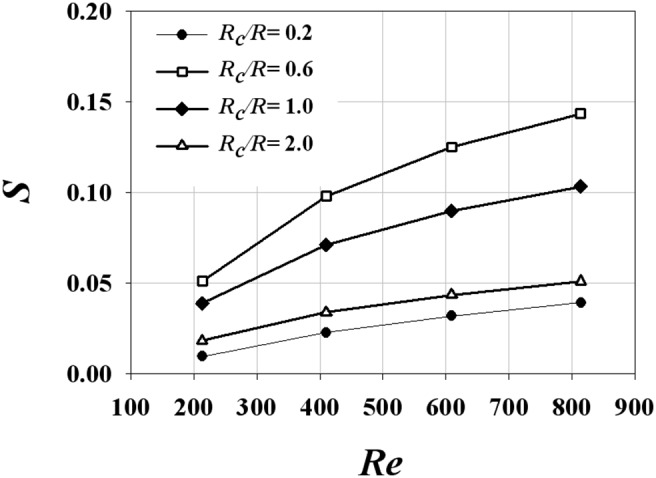
Effect of Re on the variation of swirling intensity (S) at H/R0 = 8.